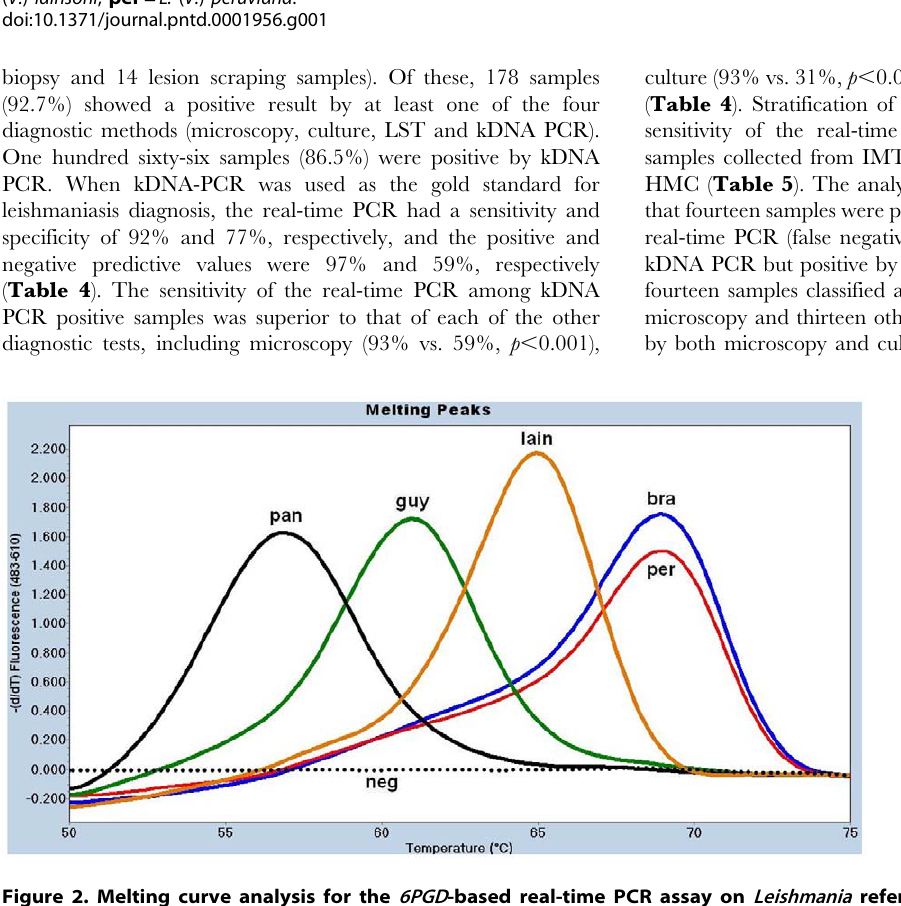
Figure 1. Melting curve analysis for the MPI -based real-time PCR assay on Leishmania reference strains. Five nanograms of DNA (references) or 5 ul of nested-PCR products (samples) were used as template to run the assay. The species designation is given based on the Tm calculated for each melting peak (point in the x axis for the peak of the curve). FRET probes on L. ( L. ) amazonensis ( ama ) or L. ( L. ) mexicana ( mex ) DNA are melted at lower temperature (53 u C) while on L. ( V. ) braziliensis ( bra ) DNA are melted at the highest temperature (74 u C). This assay could not differentiate between L. ( V. ) guyanensis ( guy ) and L. ( V. ) panamensis ( pan ) due to their overlapping Tm (72 u C). All assessed Leishmania species yielded a melting curve. A straight dotted line corresponds to the negative controls ( neg ), DNA free or parasite-free human DNA. inf = L. infantum ; lain = L.